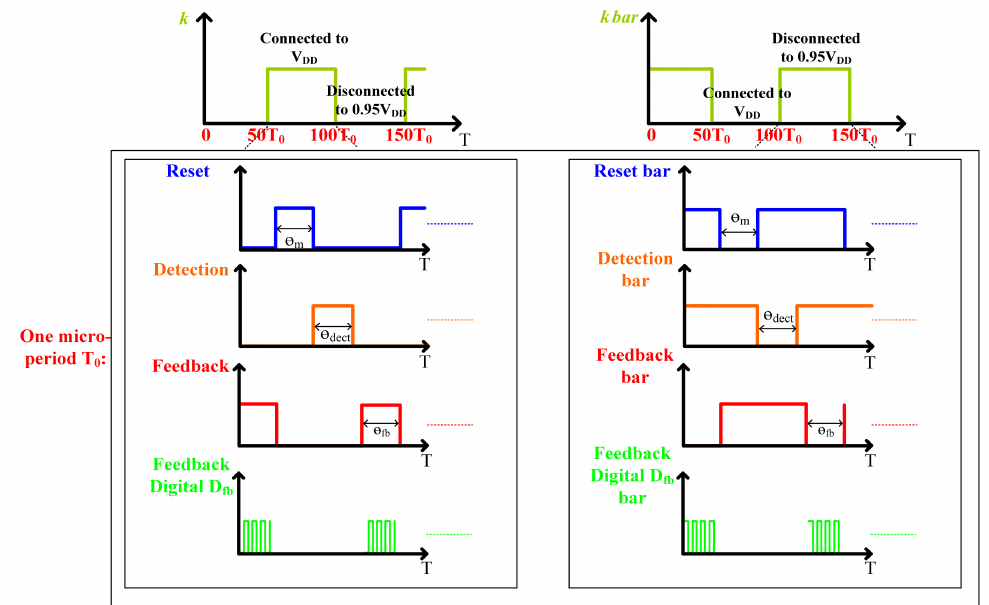
Figure 8. Timing diagram of the switched